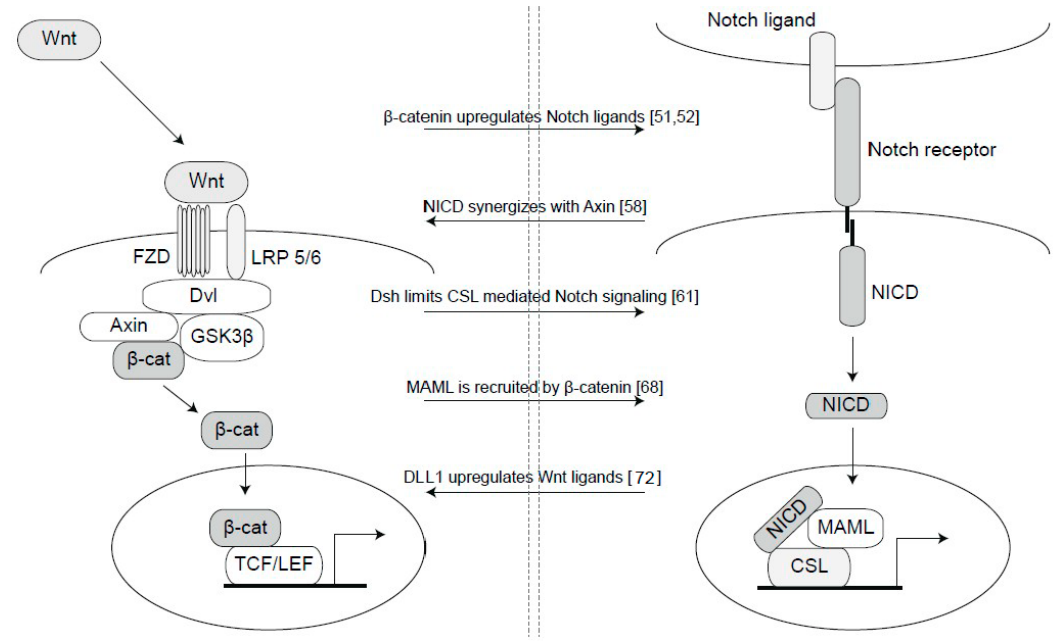
Figure 2. Nodes of interaction between Notch and Wnt signaling. There are a number of interaction nodes between Notch and Wnt signaling, and in the Figure a subset of these are schematically depicted, and the mode of interaction is described in references [51,52,58,61,68,72] (from top to